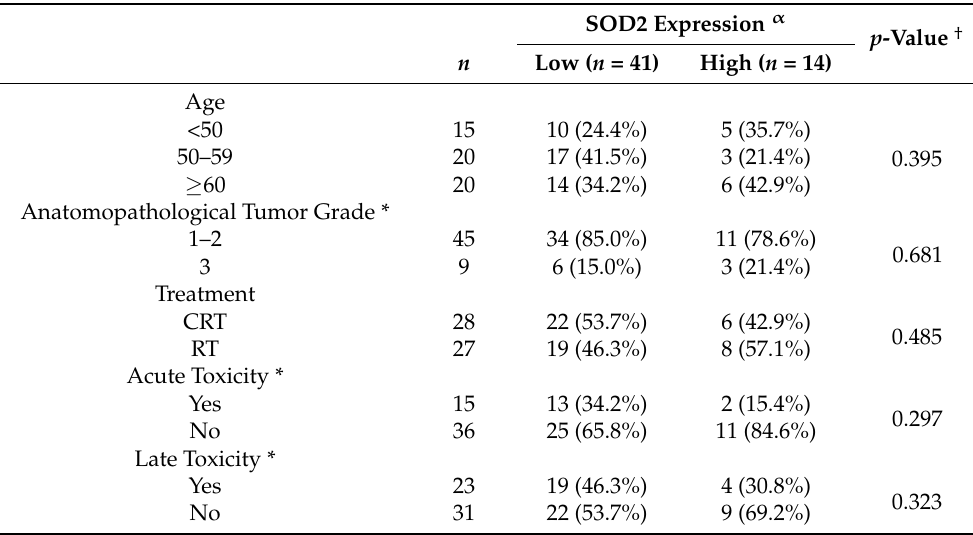
Table 1. Association between SOD2 protein and clinicopathological characteristics in cervical cancer IIIB.